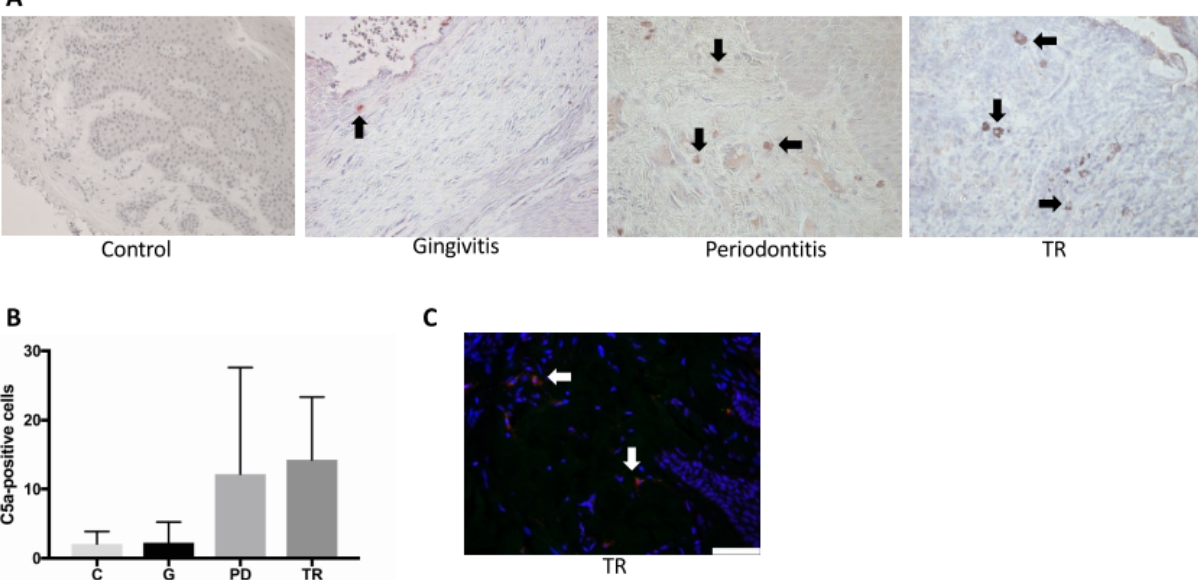
Figure 5. ( A ) Immunohistochemical staining of C5a in the gingiva of the controls (C) ( n = 4) and of cats affected by gingivitis (G) ( n = 6), periodontitis (PD) ( n = 9) or tooth resorption (TR) ( n = 12). Images were obtained at 400 × magnification. No positive cells were observed in the control section. In the gingivitis section, a single positively stained cell was seen, marked by a black arrow. In the other two groups, notably more cells could be seen. ( B ) There was a trend for an increase in positively stained cells in the PD and TR groups compared with the other two groups. ( C ) Double immunofluorescence staining in the gingiva of a tooth affected by TR. Scale bar 50 μm. Mast cell granules (Avidin) were stained red, while C5a was stained green. Mast cells positive for C5a were observed, marked by white arrows.